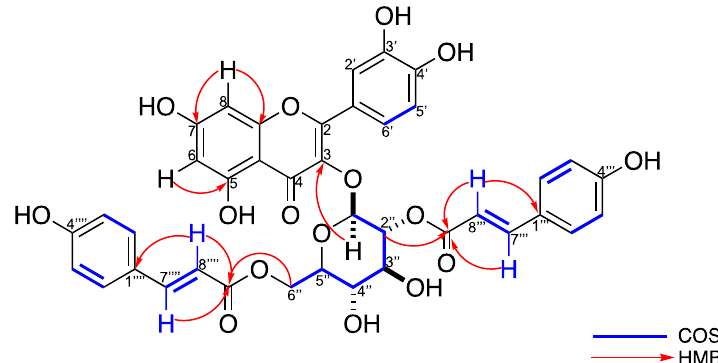
Figure 2. COSY and HMBC correlations for 6